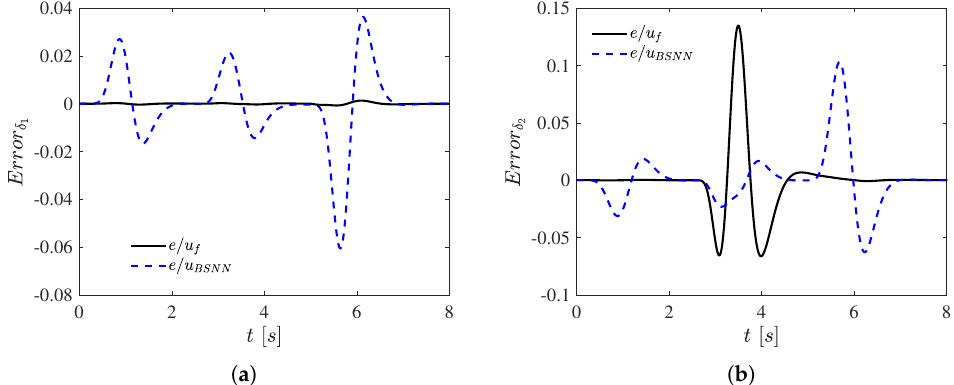
Figure 9. Load angle reference trajectory tracking errors for ( a ) generator 1; ( b ) generator 2.